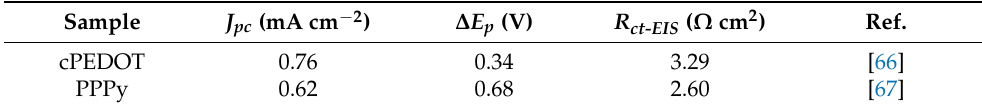
Table 4. The electrochemical parameters of various conductive polymer electrocatalysts under I − /I 3 − redox